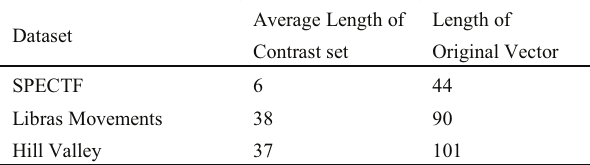
Table 6. Average lengths of the discovered contrast sets of the SPECTF, the Libras Movements and the Hill Valley